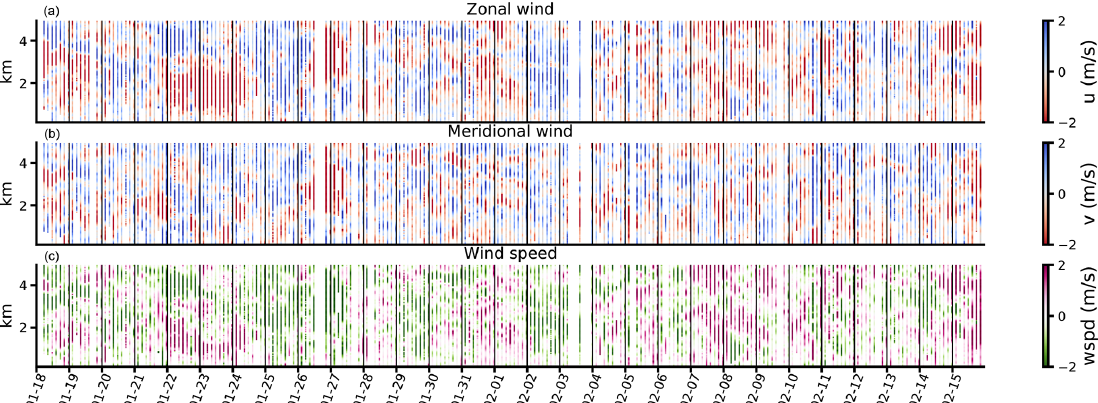
Figure 10. Difference between ERA5 and radiosonde wind profiles averaged over the whole domain and over 3-hourly intervals. From top to bottom: zonal winds, meridional winds, and wind speed.